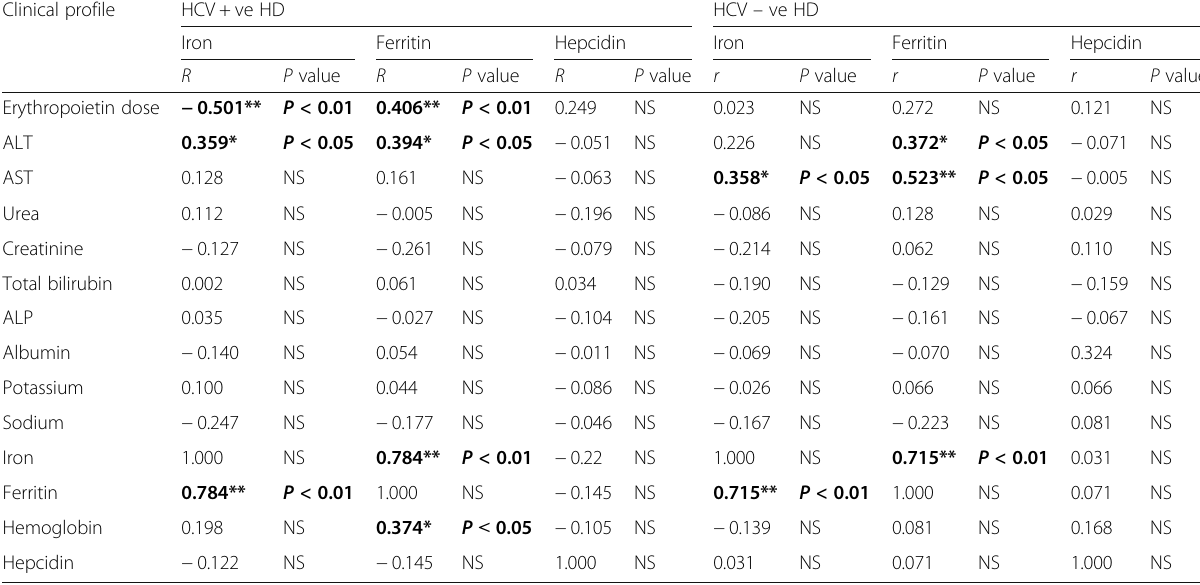
Table 3 Correlation between hepcidin and iron status markers with clinical profile in hemodialysis HCV seropositive and seronegative patient Clinical